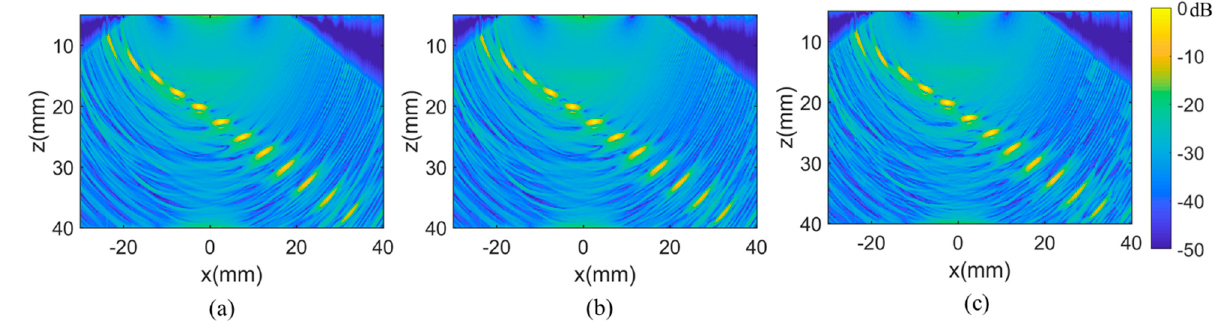
Figure 9. The optimized PWI imaging of ( a ) 61, ( b ) 31, ( c ) and 16 plane waves.